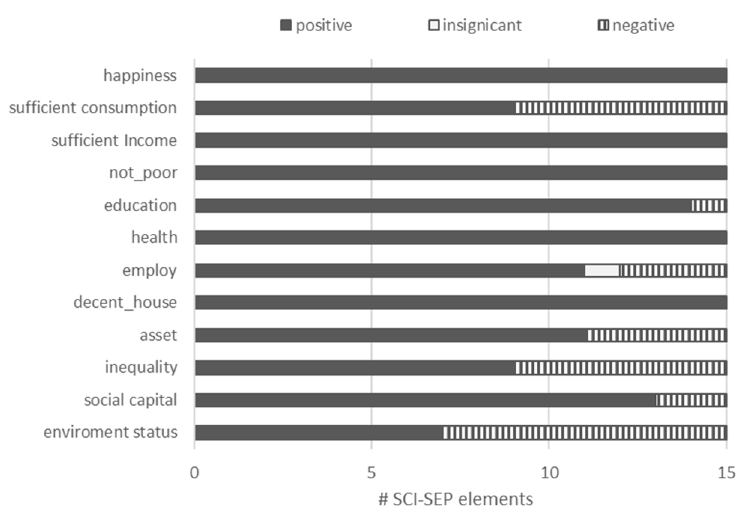
Figure 3. Correlation coefficients between each development outcome and SEP